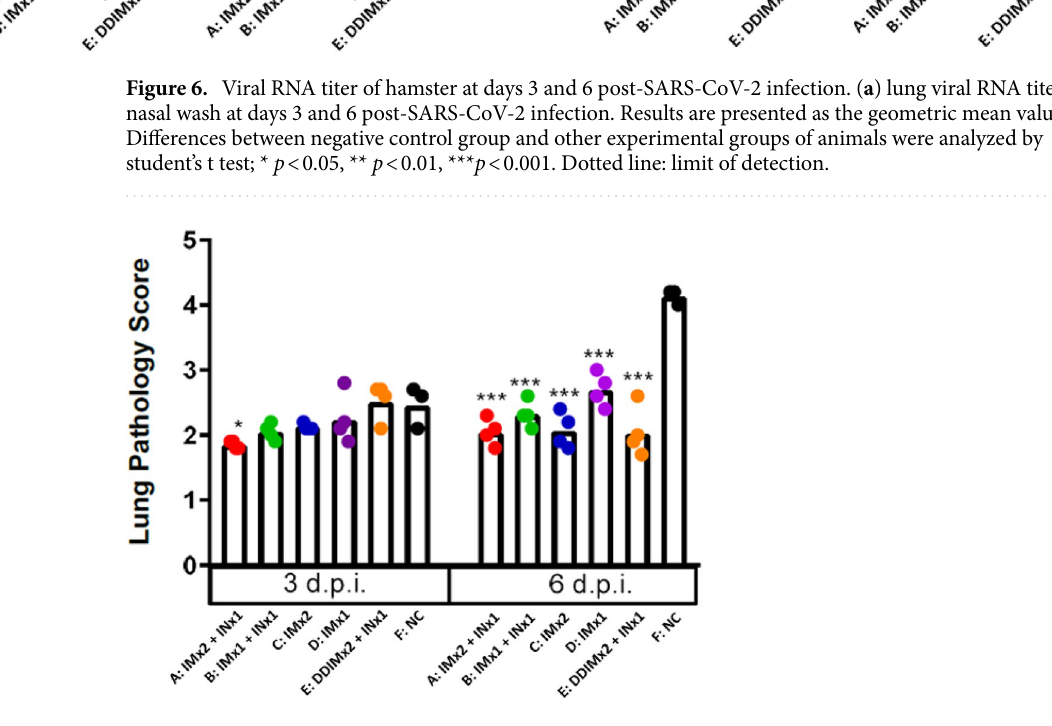
Figure 7. The clinical scoring of hamsters at day 3 and 6 post-SARS-CoV-2 infection. Results are presented as the mean values. Differences between negative control group and other experimental groups of animals were analyzed by student’s t test; * p < 0.05, ** p < 0.01, *** p <